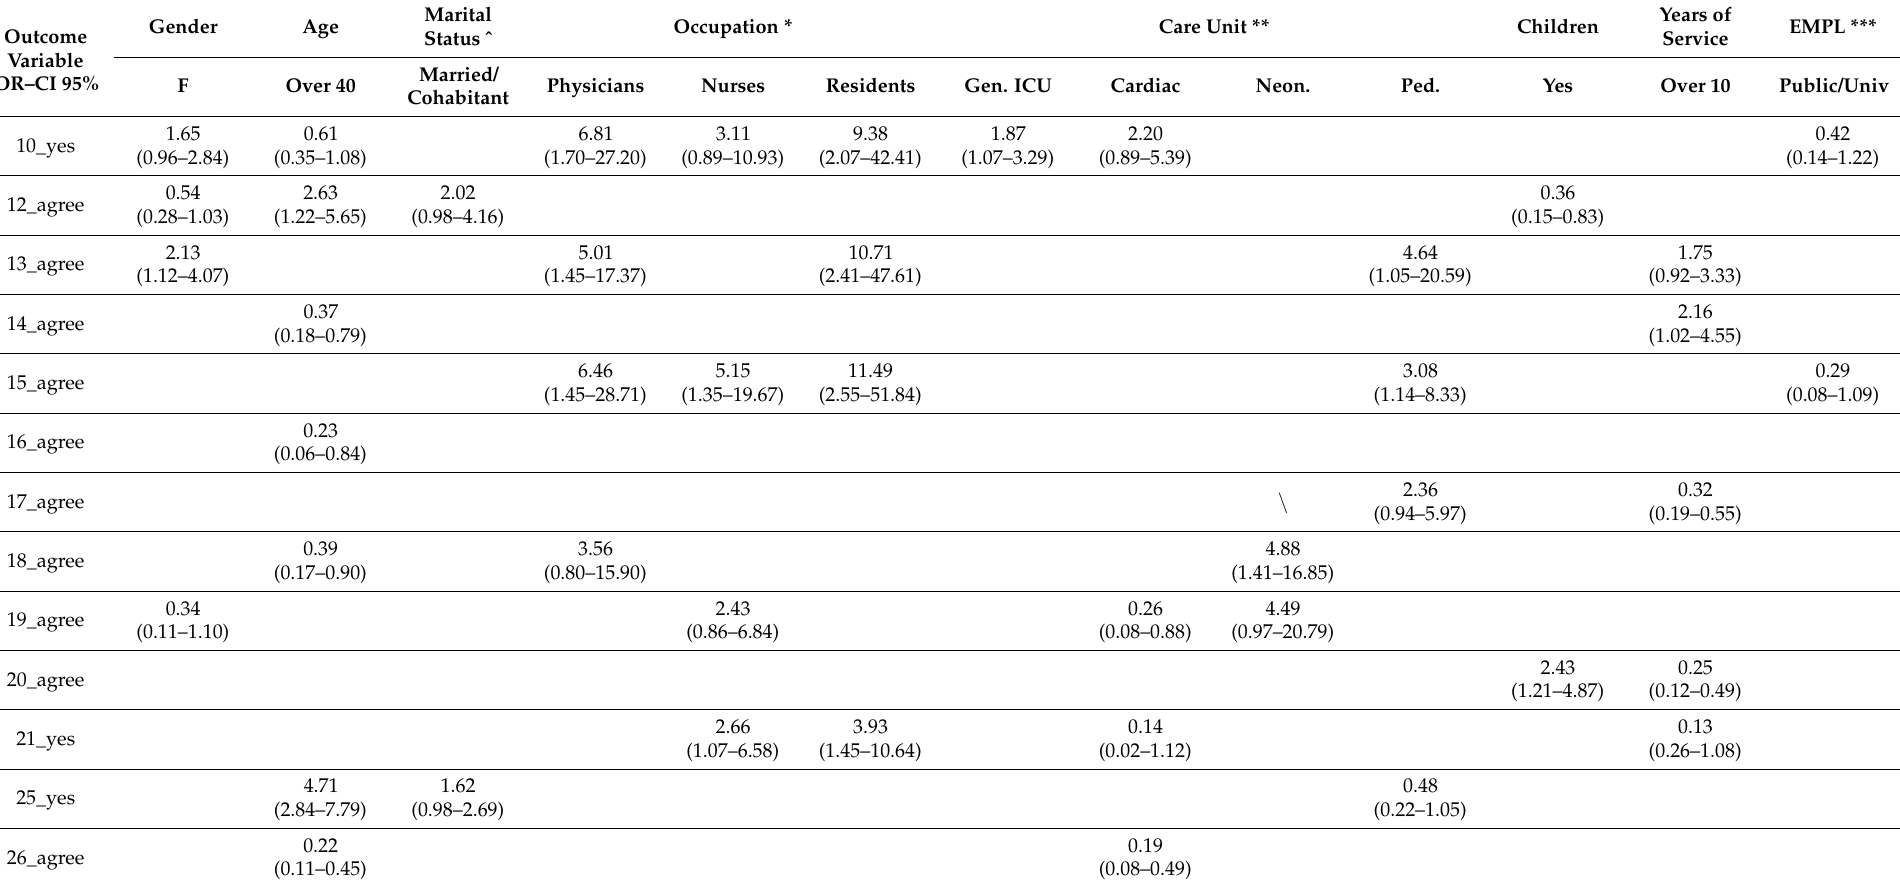
Table 4. Results of multivariate analysis—OR (95%CI) positive